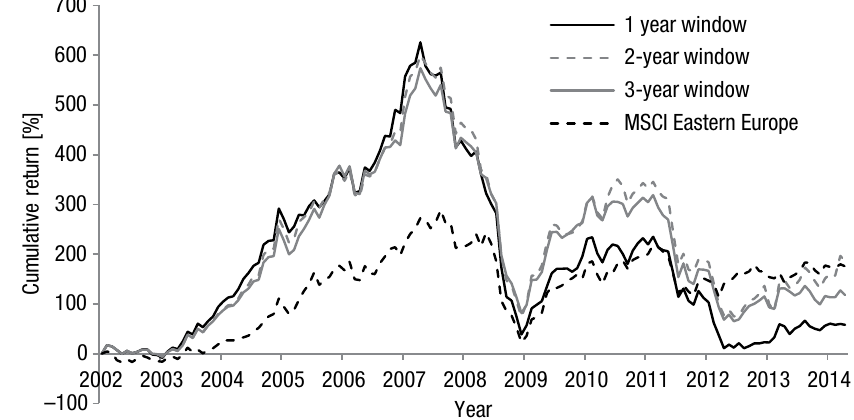
Fig. 3. Long-run cumulative returns on equally weighted portfolios of acquiring companies